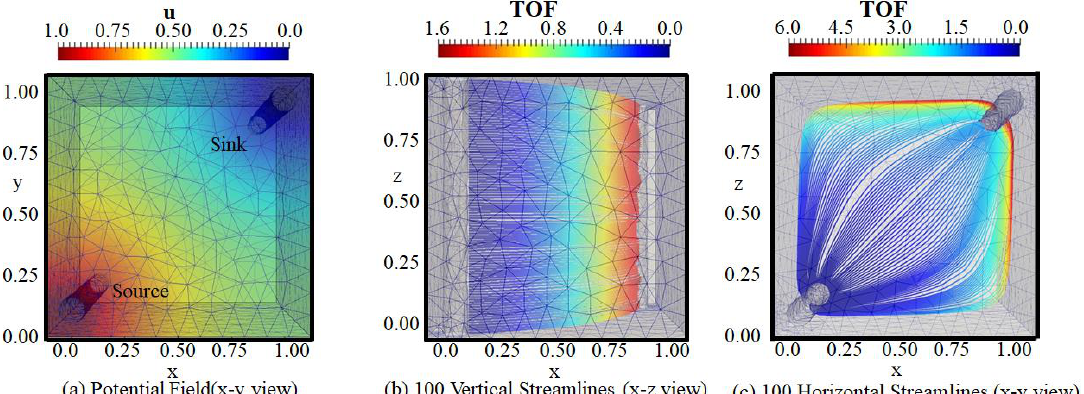
Figure 7. The result of Case 2. ( a ) The discretization of the calculation domain and the potential field (u), ( b ) and ( c ) show the streamline pattern from the x-y plane view and x-z plane view, respectively. ( u ), ( b , c ) show the streamline pattern from the x - y plane view and x-z plane view,